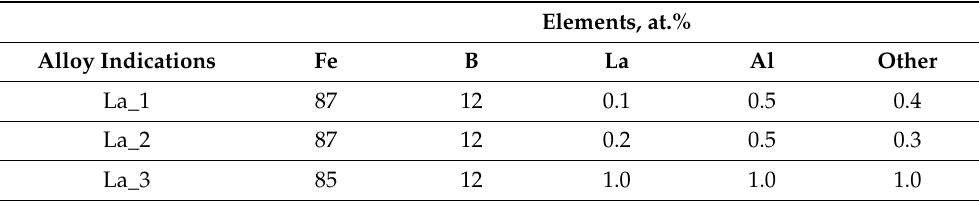
Table 1. The chemical composition and designations of the tested Fe-B-La-Al alloy, at.%. The accuracy of the main elements is about 4 wt.% and minor and trace elements are in a range of 20–50 wt.%. Elements, at.% Alloy Indications Fe